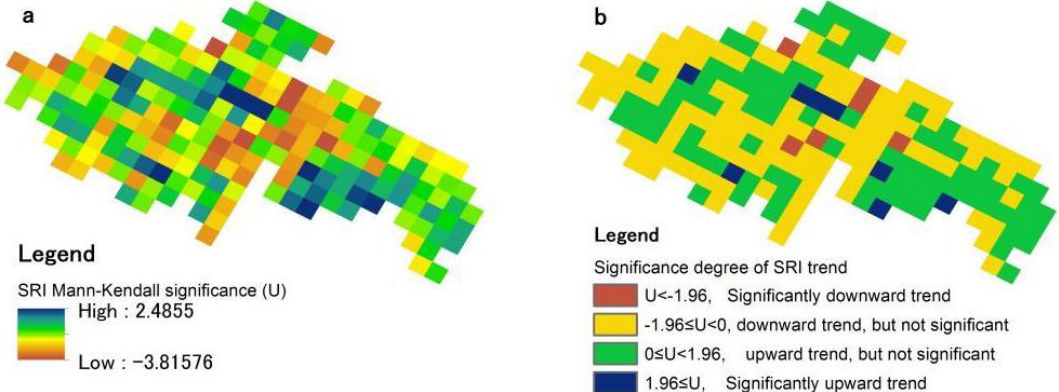
Figure 9. ( a ) The stands regrowth index (SRI) significance distribution using a non-parametric Mann-Kendall test and ( b ) the degree of significance degree for the post-fire stands regrowth index (SRI) trend using a non-parametric Mann-Kendall